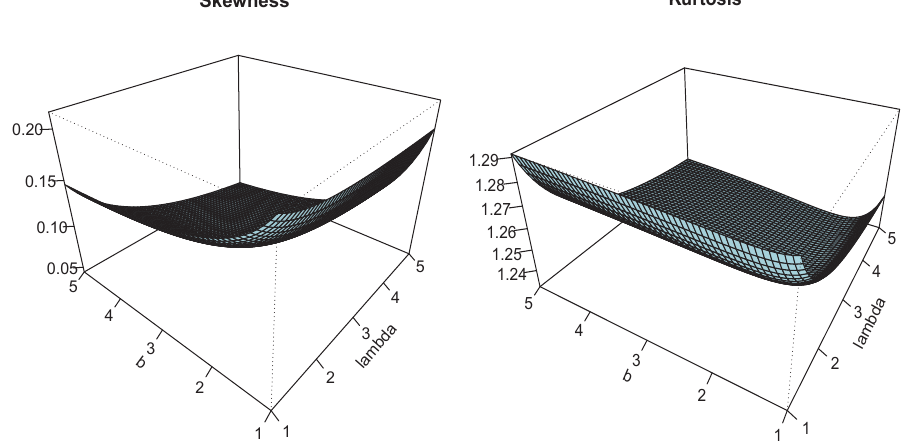
and γ ∗ for λ , b ∈ ( 1,5 ) and a = 2 1